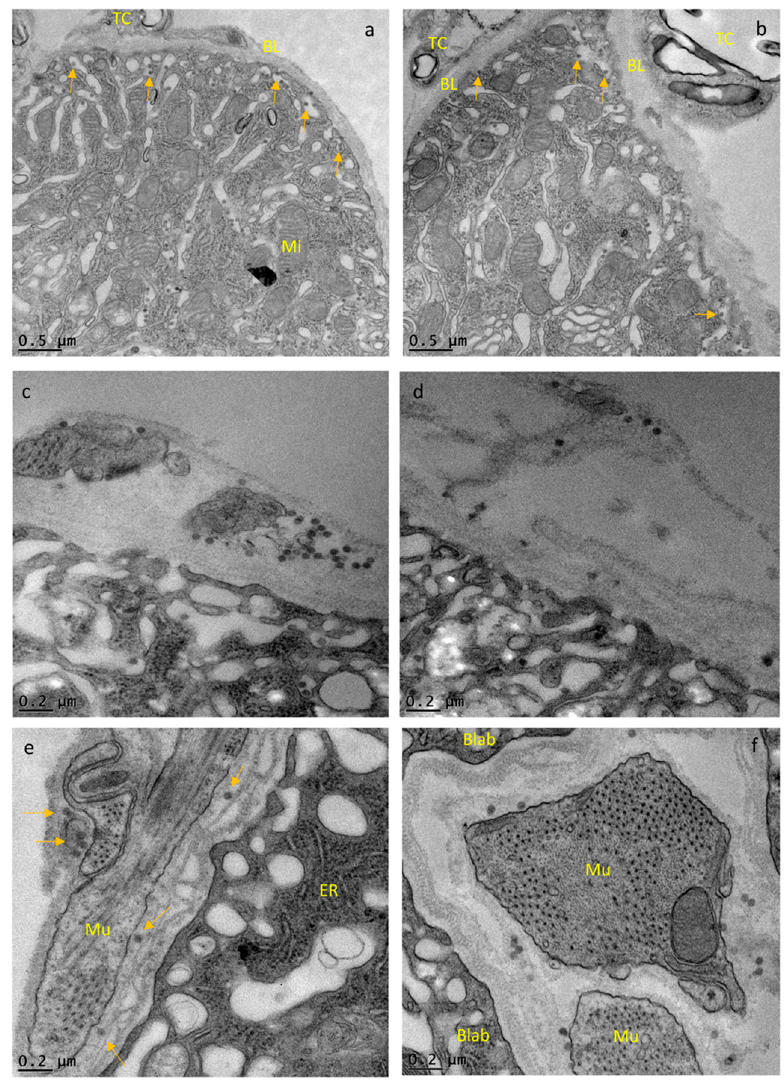
Figure 6. Ultrastructural (TEM) examination to assess how multiple bloodmeals affect CHIKV dissemination from the midgut of Ae. aegypti . Midgut cross-sections of females that had received either a single CHIKV containing bloodmeal (titer in the bloodmeal: 10 7 pfu/mL) or an initial bloodmeal containing CHIKV followed by a non-infectious (NI) bloodmeal were analyzed. ( a , b ) Mature CHIK virions are dispersed throughout the cavities of the basal labyrinth of the infected midgut epithelial cell at 5 days post-initial, infectious bloodmeal. Occasionally, single virions are visible close to the BL (orange arrows). ( c , d ) At 24 h post-second (NI) bloodmeal (144 h post-initial CHIKV containing bloodmeal), virions are found within strands of the BL and attached to the side of the BL facing the hemocoel suggesting that these virions have traversed the BL. Occasionally, virions are also found to be attached to BL fragments that are largely detached from the main BL surrounding the midgut organ. ( e , f ) At 32 h post-second (NI) bloodmeal (152 h post-initial CHIKV containing bloodmeal), virions are still present between strands of the BL or associated with the hemocoel facing side of the BL, predominantly in proximity to the muscle tissue (orange arrows). ( a – f ) Images were generated using a JEOL JEM 1400 transmission electron microscope. Magnifications ranged from 2500 × to 25,000 × . BL = basal lamina; Blab = basal labyrinth; ER = endoplasmic reticulum; Mu = muscle; Mi = mitochondrion; Nu = nucleus; TC = tracheal cell.